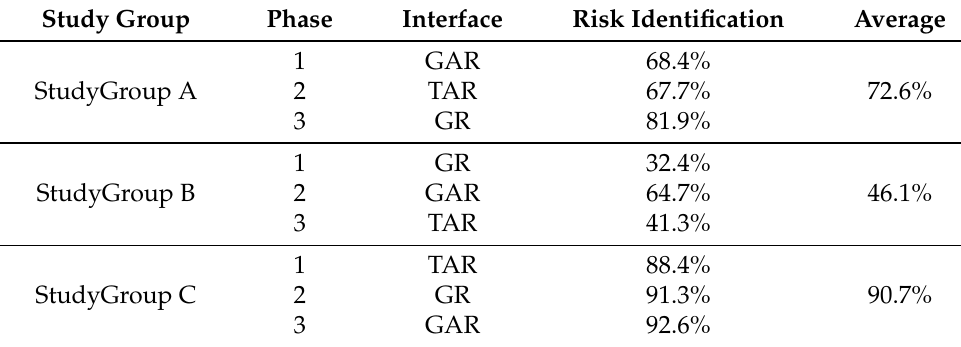
Table 5. Risk identification based on study groups.